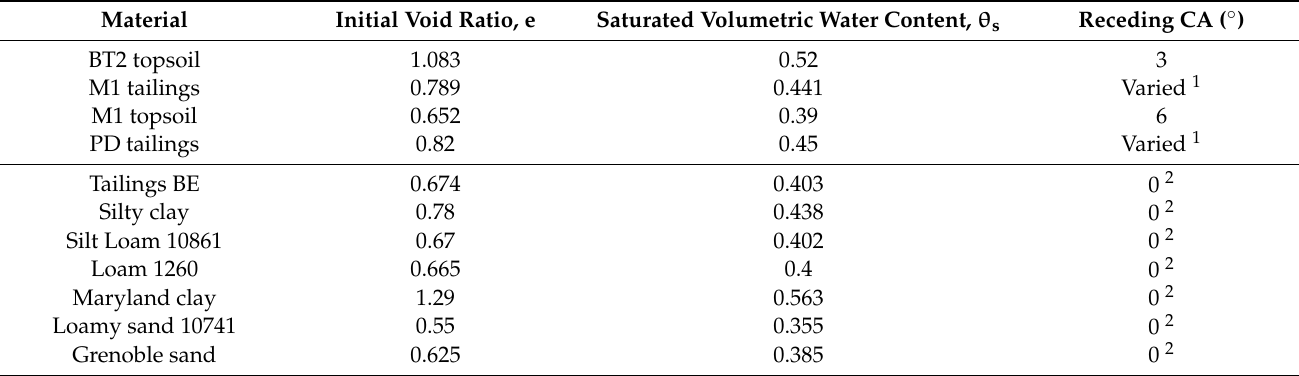
Table A3. Parameters used in the Mohammadi-Vanclooster model (MV) for each material: initial void ratio, saturated volumetric water content ( θ s ), and receding contact angle (CA).